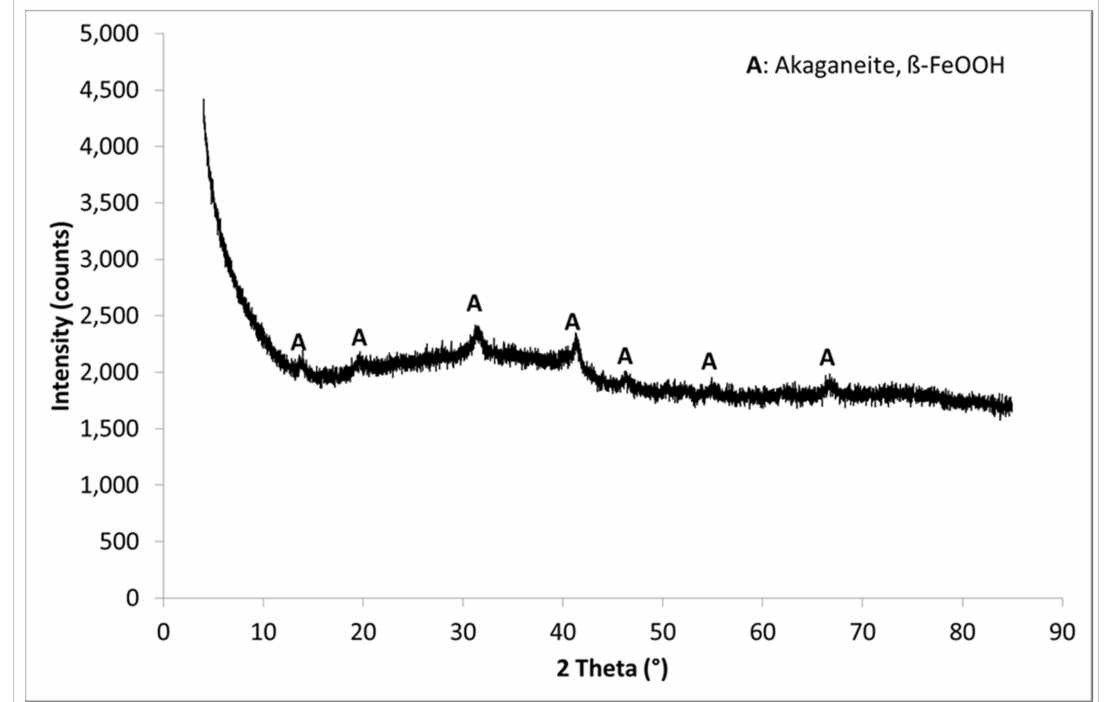
Figure 5. XRD pattern of the abrasion product obtained from Ferrodecont treatment of sample